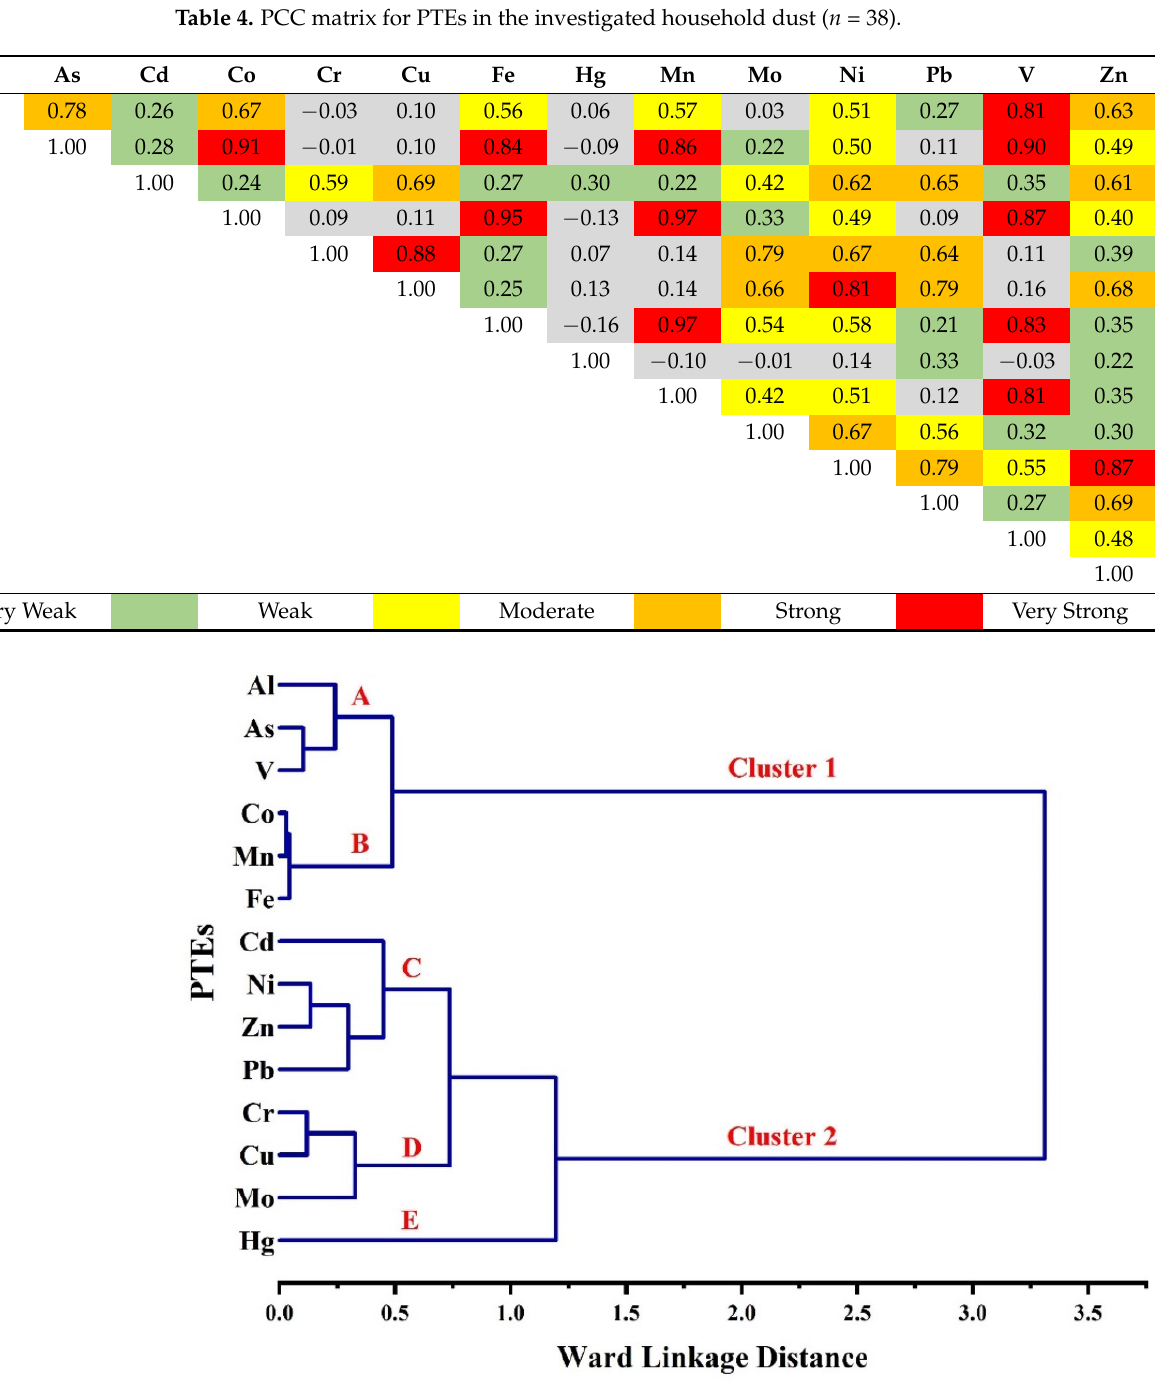
Figure 5. HCA dendrogram.